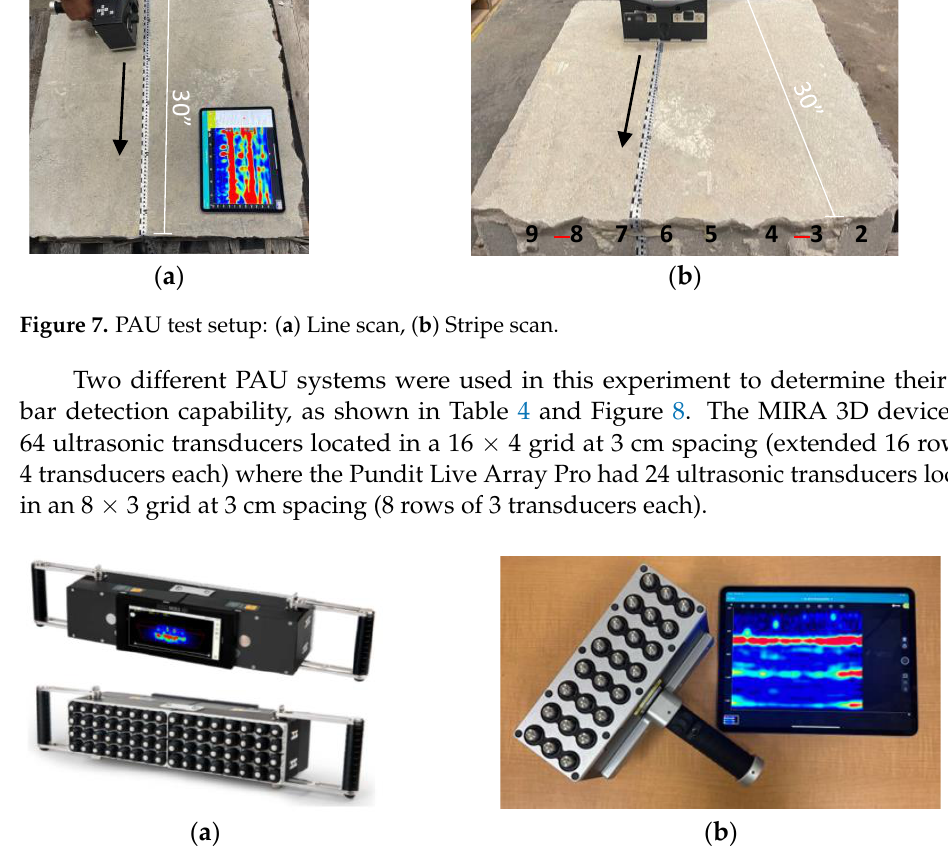
Figure 8. PAU systems used: ( a ) A1040 MIRA 3D (two devices were attached side by side to increase the number of channels to 16 rows of 4 transducers each) [115], ( b ) Pundit live array pro.